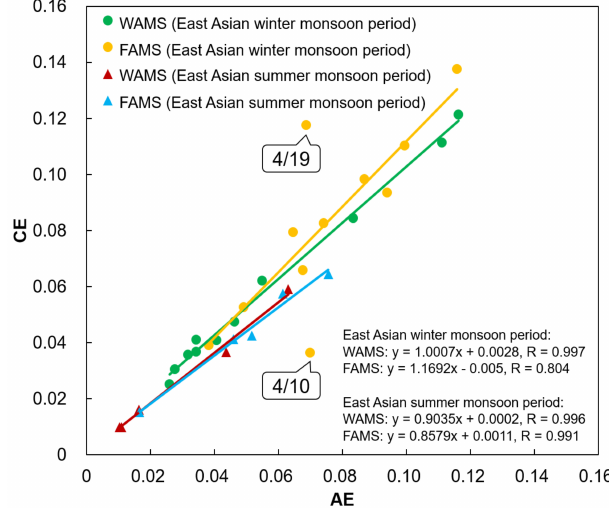
Figure 7. WSII acid–base balance at WAMS and FAMS in the East Asian winter monsoon period (Period 1, 10–20 April 2017) and summer monsoon period (Period 2, 25–29 June